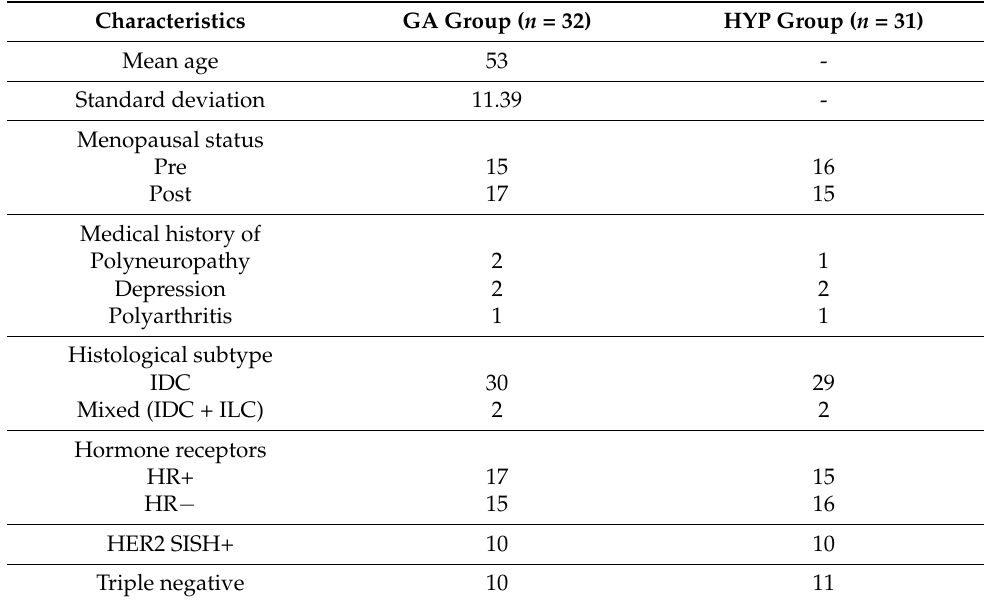
Table 1. Patients and tumor characteristics.